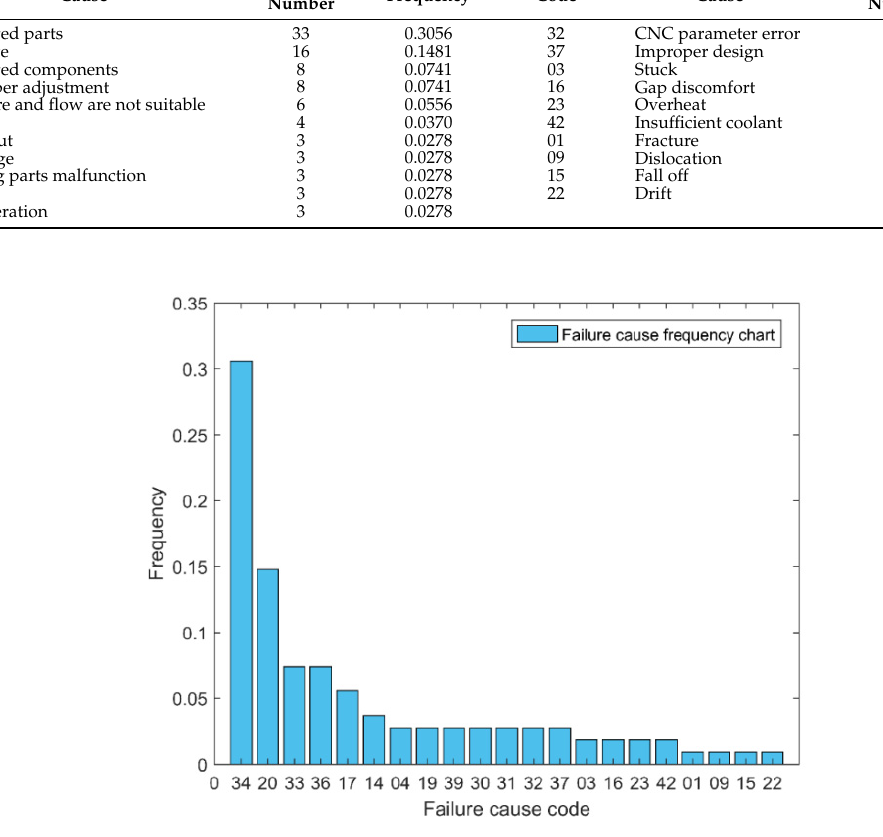
Table 4. Model parameter of failure rate of each component of machining center.